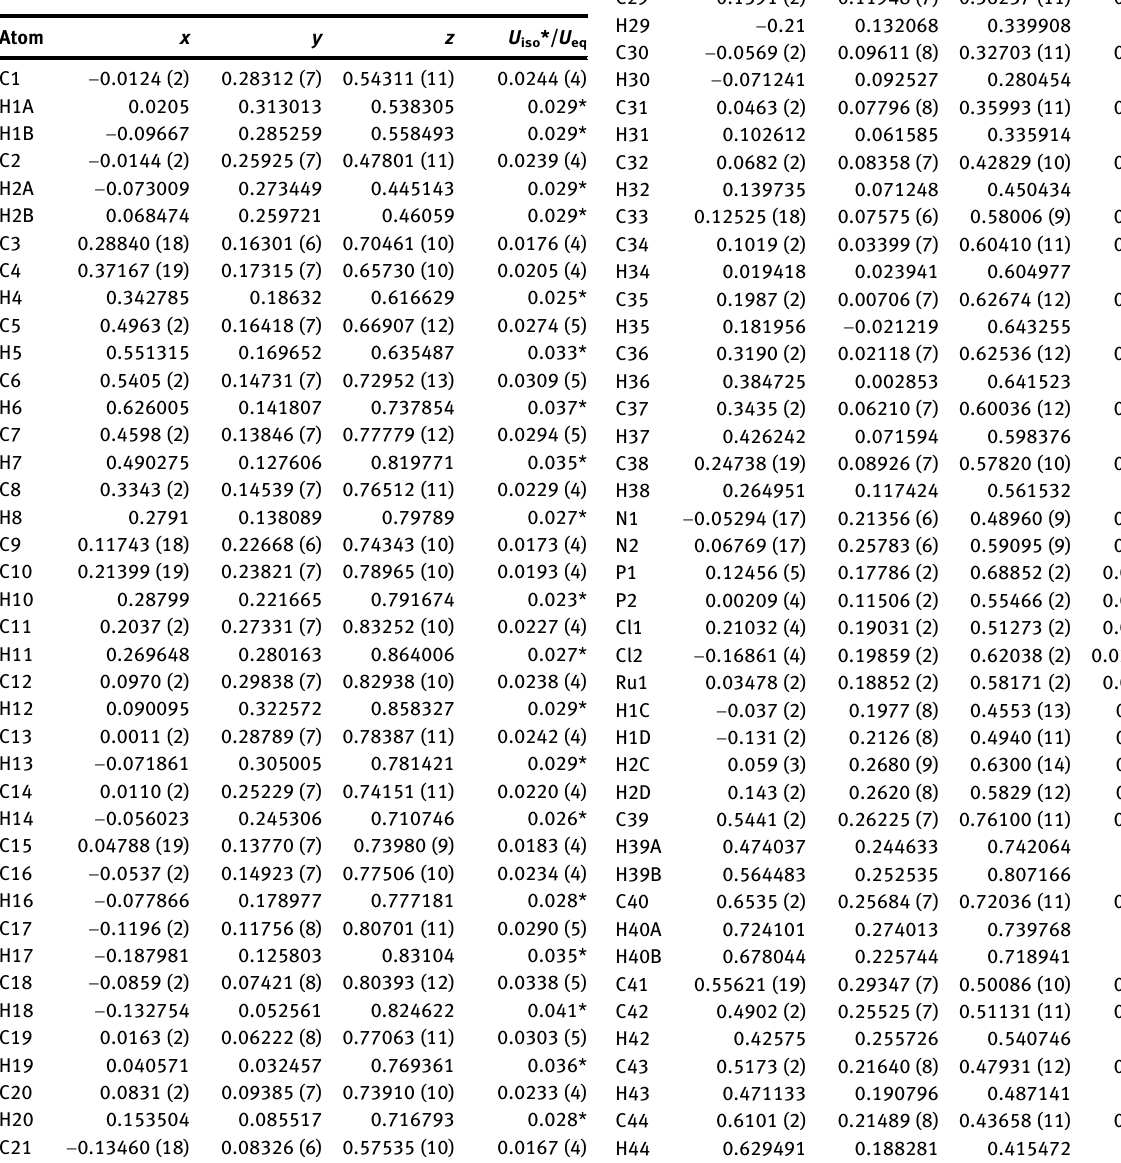
Table  : Fractional atomic coordinates and isotropic or equivalent isotropic displacement parameters (Å 